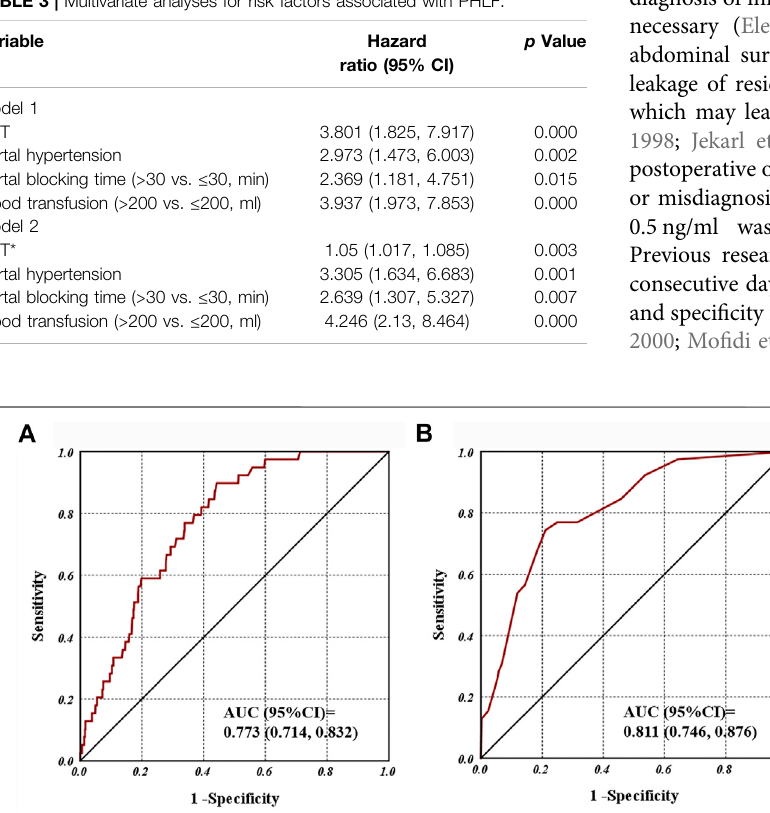
Frontiers in Pharmacology |